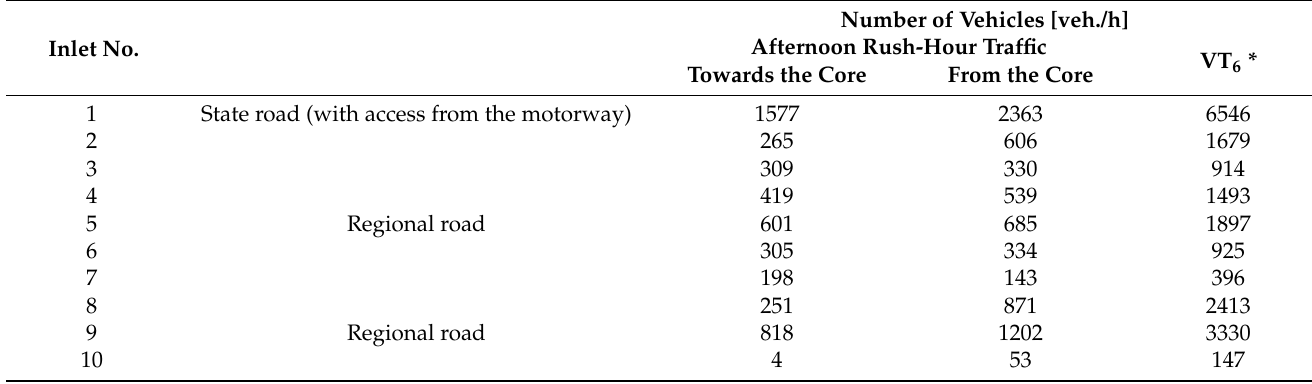
Table 13. Characteristics of inlets to the core (Pozna´n) from the survey in the year 2013.